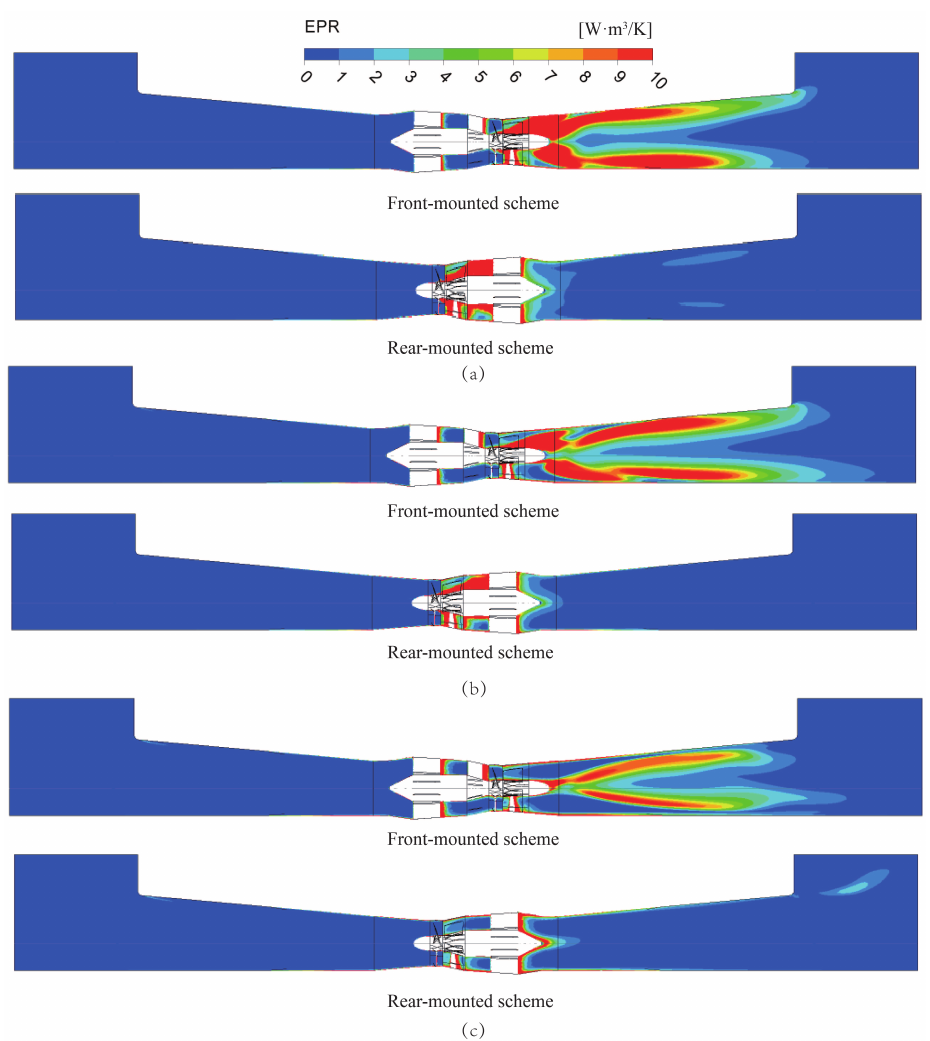
Figure 13. Distribution of entropy production rate inside the pump device under different flow conditions: ( a ) 0.8 Q d ( b ) 1.0 Q d ( c ) 1.2 Q d